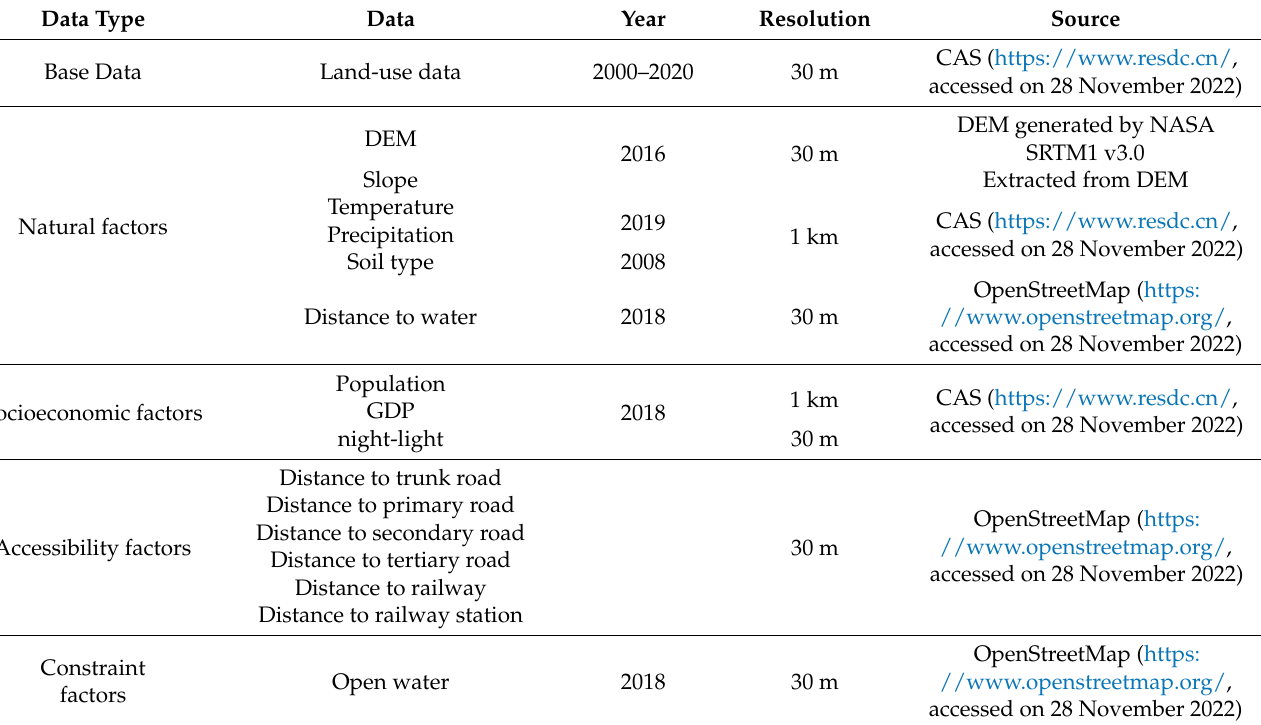
Table A1. Coefficients of ecosystem service value (ESV) per unit area in study area. (RMB/ha/year).